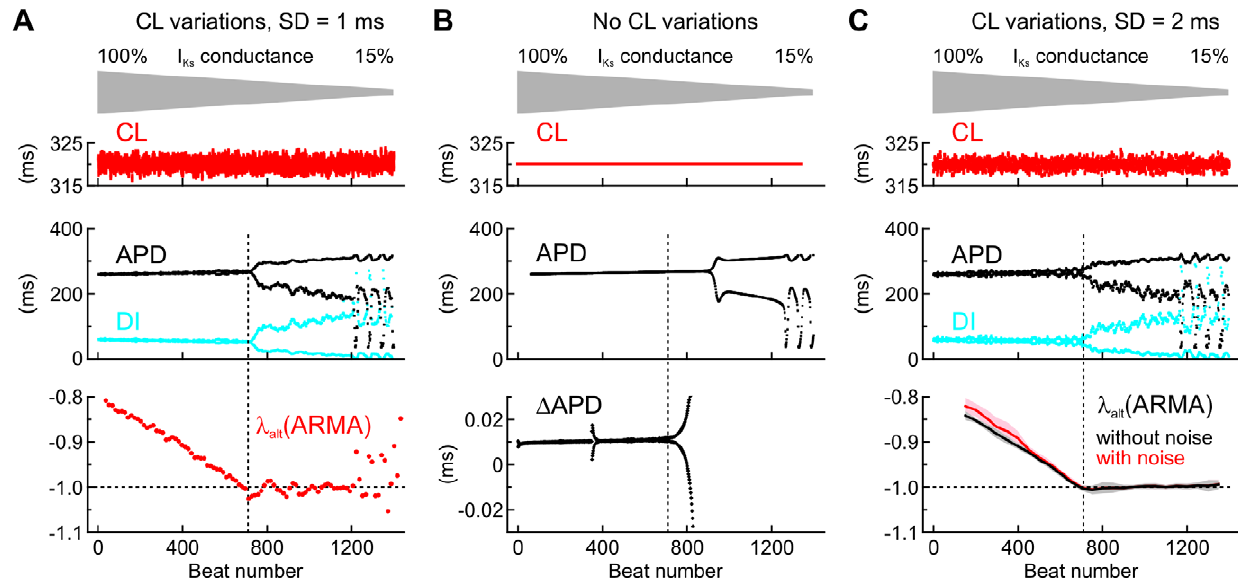
Figure 7. Predicting alternans in the V m -driven model during a progressive decrease of I Ks conductance. A : CL, APD, DI and l alt during stochastic pacing (mean CL: 320 ms; SD of variations: 1 ms). l alt was estimated every 15 beats using a 2 nd order ARMA model from APDs and CLs in a window spanning the 30 preceding cycles. B : CL, APD and the difference series of APD ( D APD) when pacing at a CL=320 ms without variations. C : Top : CL, APD and DI during stochastic pacing (mean CL: 320 ms; SD of variations: 2 ms). Middle and bottom : Analysis of l alt in n =10 simulations, with and without adding a Gaussian error (SD=1 ms) to APD, simulating experimental measurement error. l alt was estimated every 75 beats using a 2 nd order ARMA model from APDs and CLs in a window spanning the 150 preceding cycles. Data are presented as mean (bold lines) 6 SD (shaded areas). In all panels, vertical dotted lines indicate the onset of macroscopic alternans (in A and C ) and of micro-alternans (in B ).